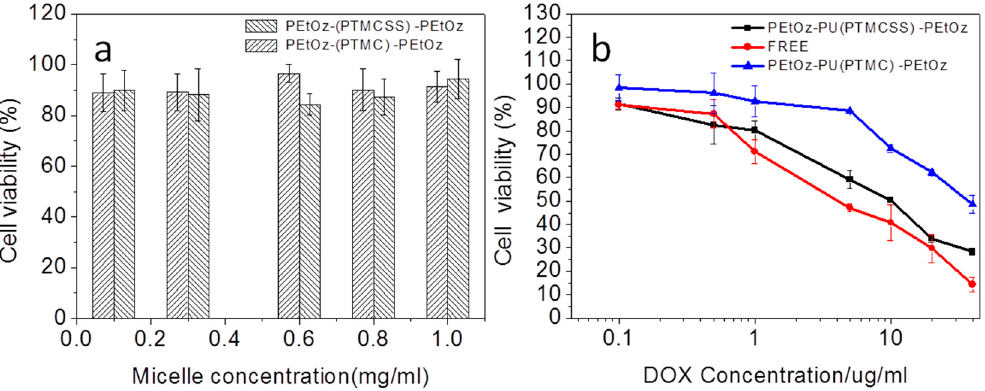
Figure 3. ( a ) Cytotoxicity of different concentration of PEtOz-PU(PTMCSS)-PEtOz and PEtOz-PU(PTMC)-PEtOz micelles, against C6 cells after 24 h incubation using 3-(4,5-dimethyl-2-thiazolyl)-2,5-diphenyl-2 H -tetrazolium bromide (MTT) assay. ( b ) Anti-tumor activity of DOX-loaded PEtOz-PU(PTMCSS)-PEtOz micelles in C6 cells. DOX-loaded PEtOz-PU(PTMC)-PEtOz micelles were used as controls. The cells were treated with DOX-loaded micelles or free DOX for 48 h. Data are presented as mean ± SD ( n = 6).